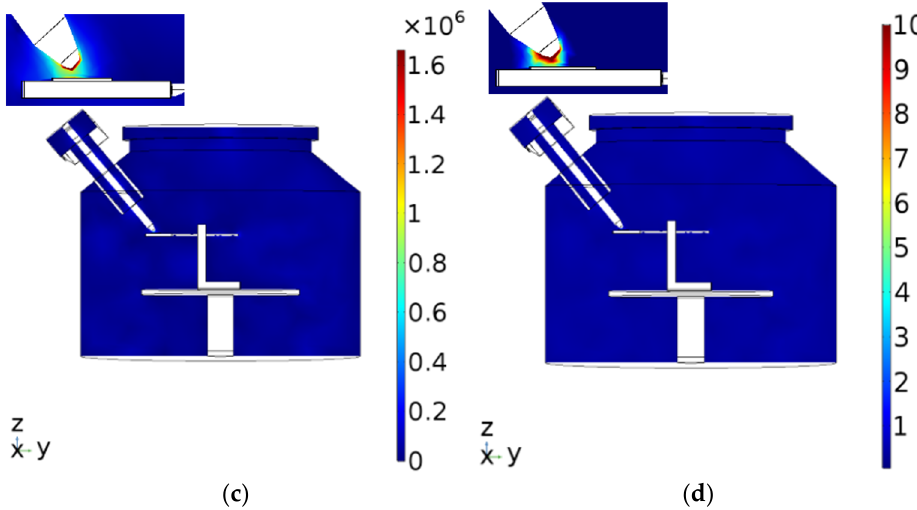
Figure 8. Distribution of ( a ) electron density, ( b ) ion density, ( c ) electric field, and ( d ) electron temperature at the sample holder height of 118 mm, microwave power of 600 W, and hydrogen gas pressure of 70 Torr in the MPJCVD system. Table 2. Collisions and chemical reactions of hydrogen (H) used in the MPJCVD model.